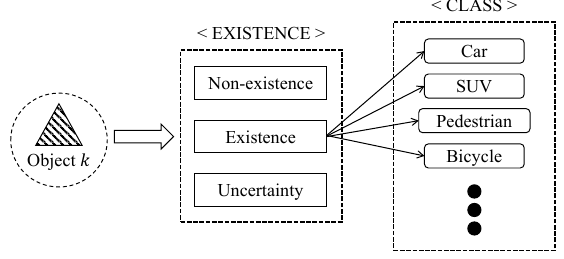
Figure 1. Determining the object type